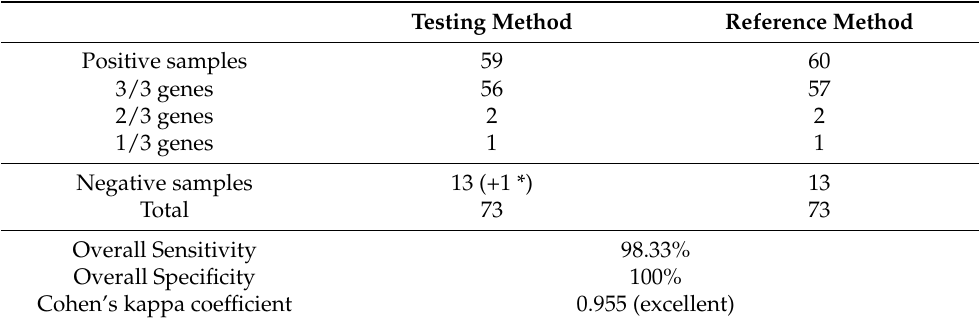
Table 1. Clinical performances of Testing method and Reference method.